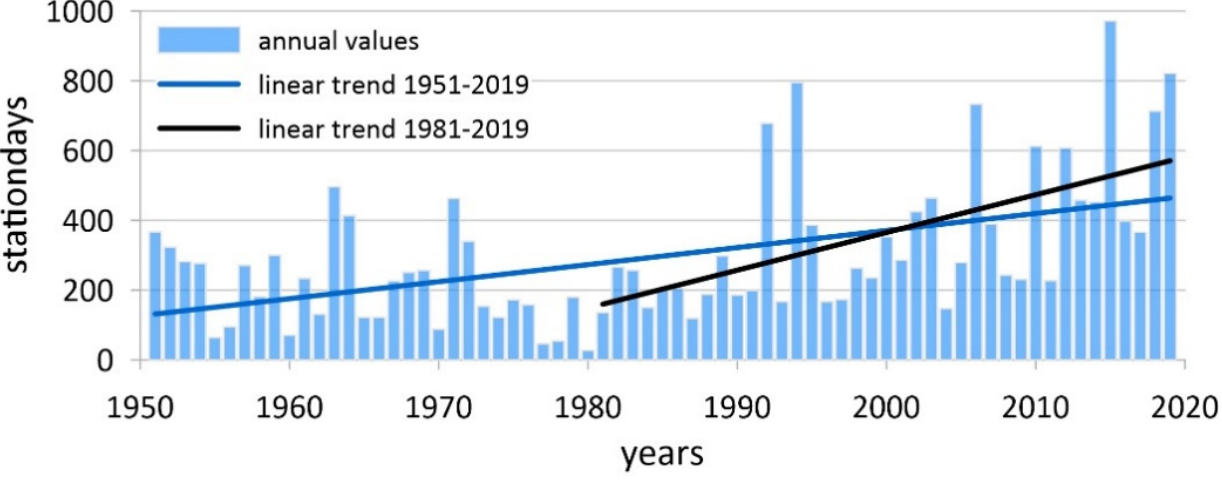
Figure 6. Annual frequencies of hot station-days in Poland in the period 1951–2019.